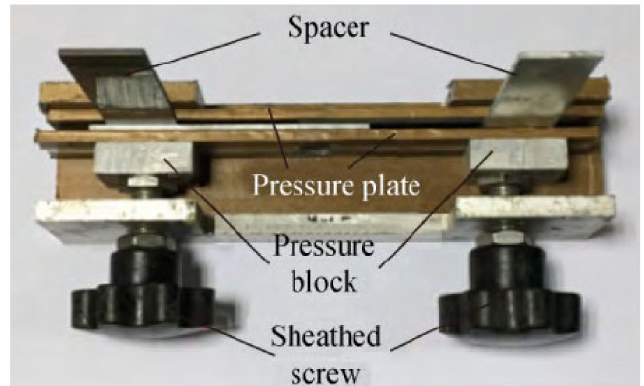
Figure 2. Adhesive fixture of single-lap